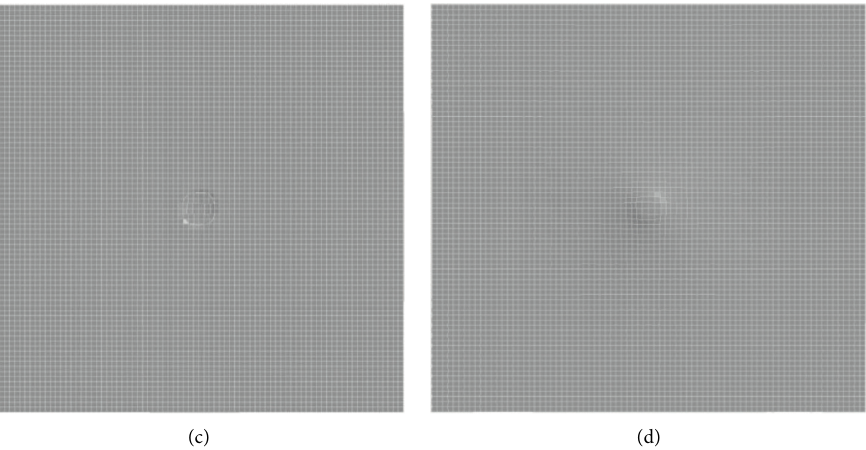
Figure 4: Comparison of SCS wall response (SCS-250-6T). (a) Front steel plate of test. (b) Rear steel plate of test. (c) Front steel plate of FEM simulation. (d) Rear steel plate of FEM simulation.